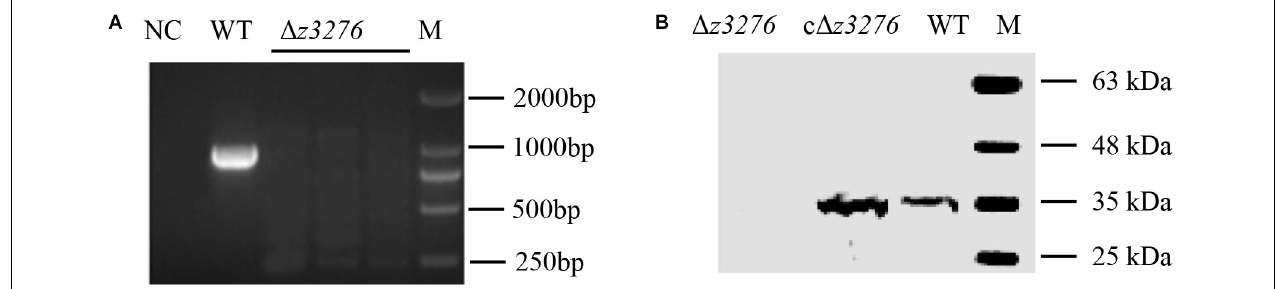
FIGURE 2 | Confirmation of the (cid:49) z3276 in EHEC O157:H7 strain 86-24. (A) Confirmation of the (cid:49) z3276 by PCR using primers P4-F/R. M, 2000-bp marker. The predicted PCR product size is 898 bp. (B) Confirmation of the (cid:49) z3276 by Western blot analysis. The predicted protein size is 33 kDa.